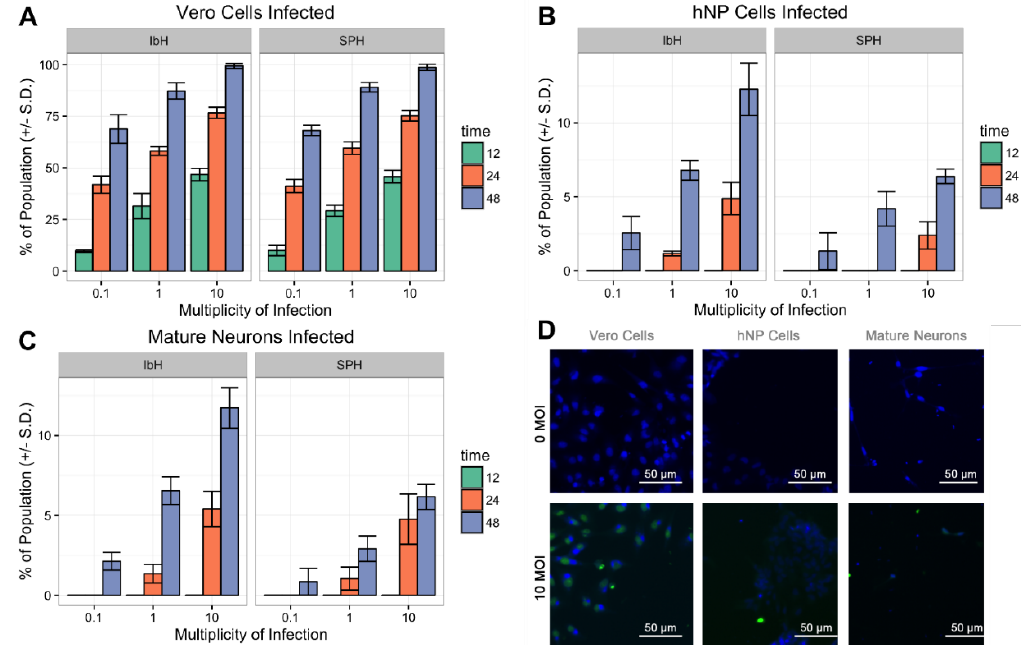
Figure 3. Isolate-dependent ability of ZIKV to infect hNP cells and mature neurons. ( A ) ZIKV isolates IbH and SPH readily infect Vero cells within 48 h. ( B ) hNP cells are more susceptible to IbH infection than SPH infection, however neither isolate infected more than 13% of the population. ( C ) Mature neurons (28 DIV) were similarly more susceptible to ZIKV IbH infection than SPH infection. ( D ) Non- infected (0 MOI) did not demonstrate ZIKV E protein’s presence, but infected (SPH 10 MOI) cells after